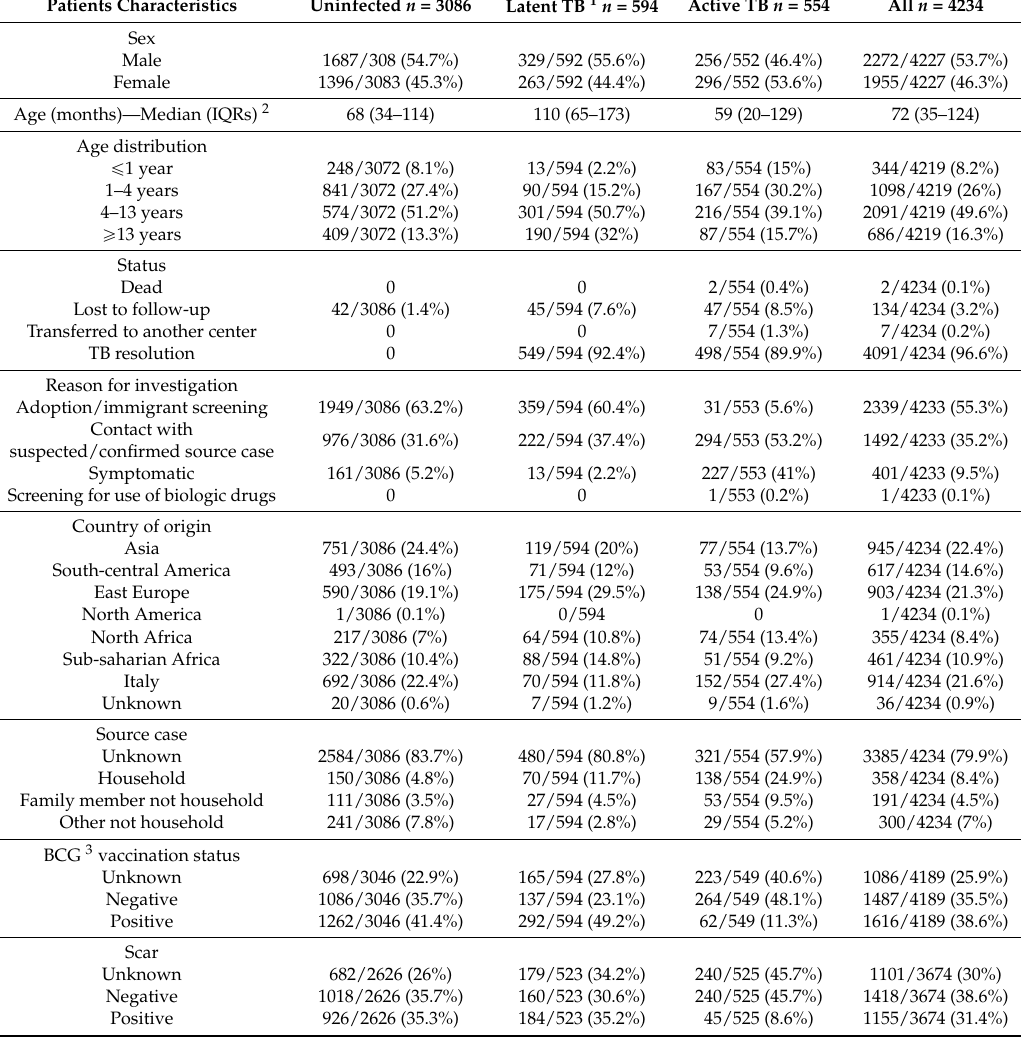
Table 1. Main characteristics of children